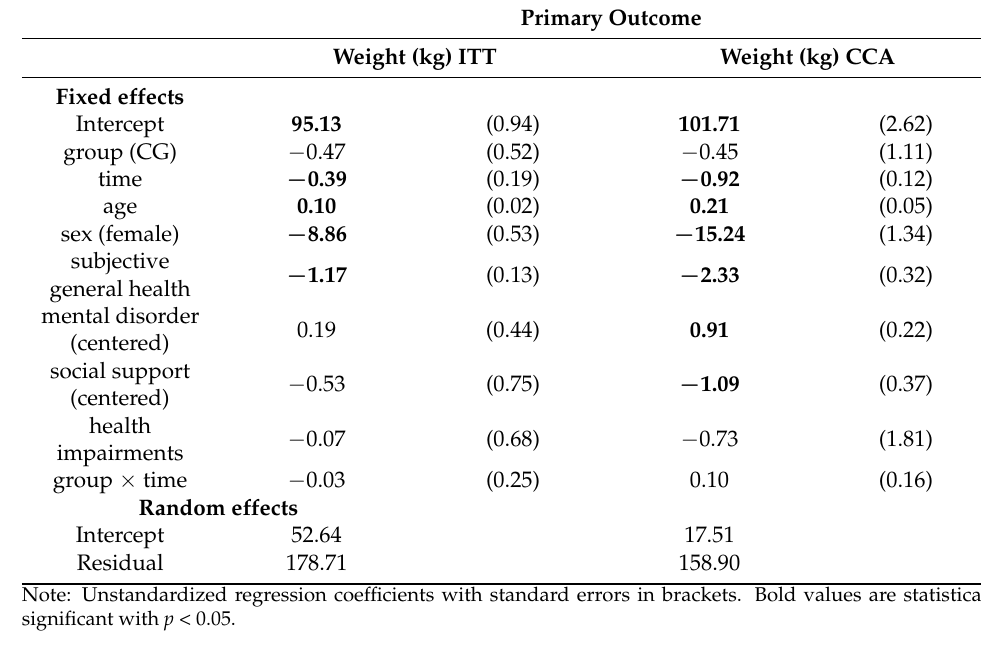
Table 2. Multi-level analyses on primary outcome (weight in kg).